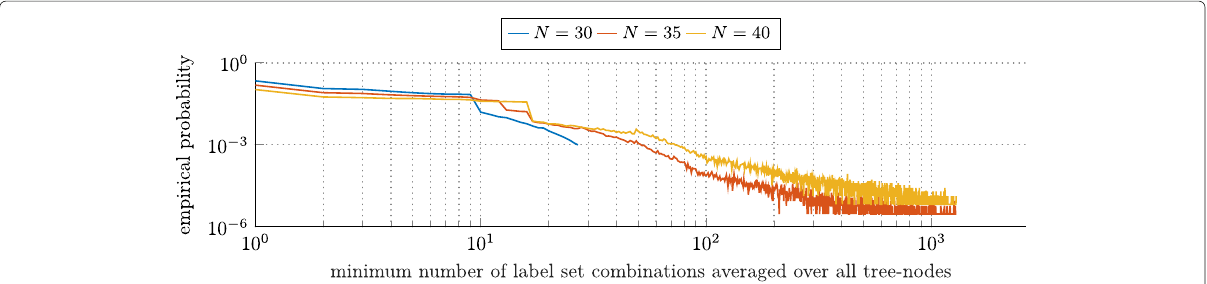
Fig. 12 Statistics of the k -ambiguity trees for 10 IDs and a varying number of sensor motes